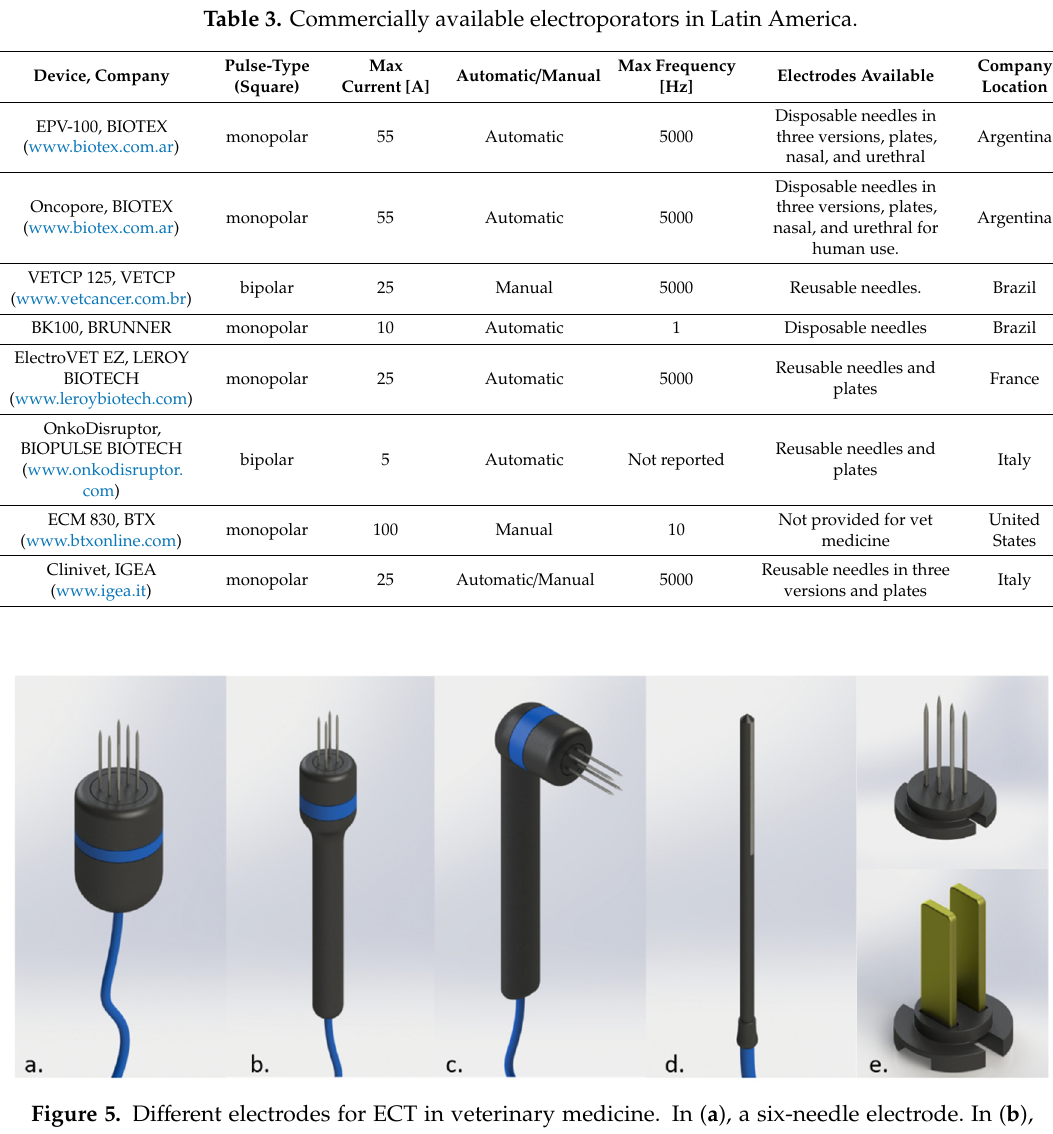
Figure 5. Different electrodes for ECT in veterinary medicine. In ( a ), a six-needle electrode. In ( b ), a four-needle electrode using thin-needles. In ( c ), a 90 degrees handle for the thin-needles electrode. In ( d ), an electrode for treating nasal duct. In ( e ), on top, disposable-needles, at the bottom, plates electrode that can be attached to the handles. Courtesy of BIOTEX SRL. Table 3. Commercially available electroporators in Latin America.